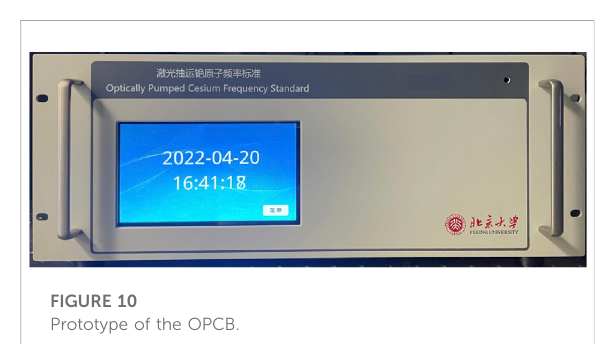
(cid:1) √ τ and the 5-day stability can reach 7 × 10 − 15 . The green line is the fi tting curve.